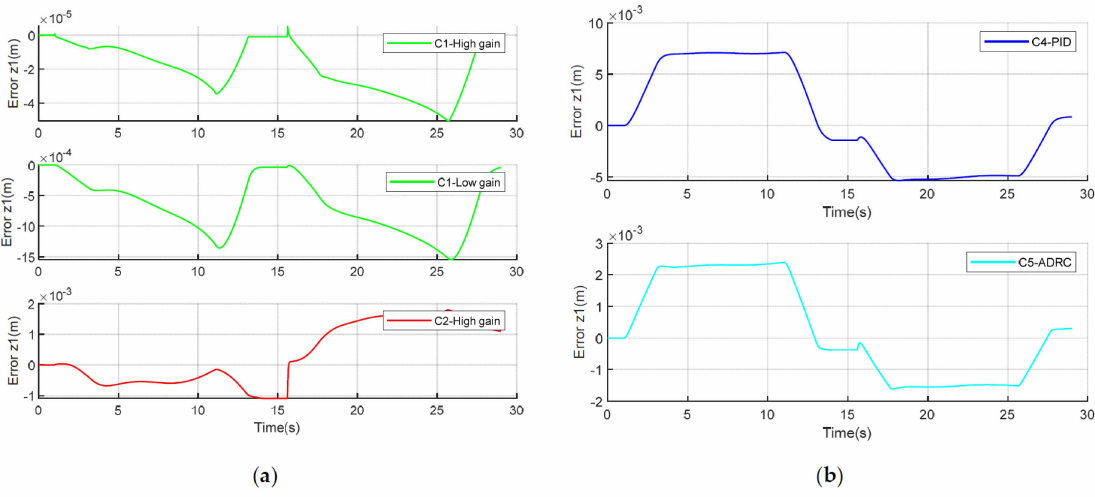
Electronics 2022 , 11 , x FOR PEER REVIEW 13 of 17 Figure 4. Tracking error. ( a ) C1 − High gain, C1 − Low gain, and C2 − High gain. ( b ) C4 − PID, C5 − ADRC.